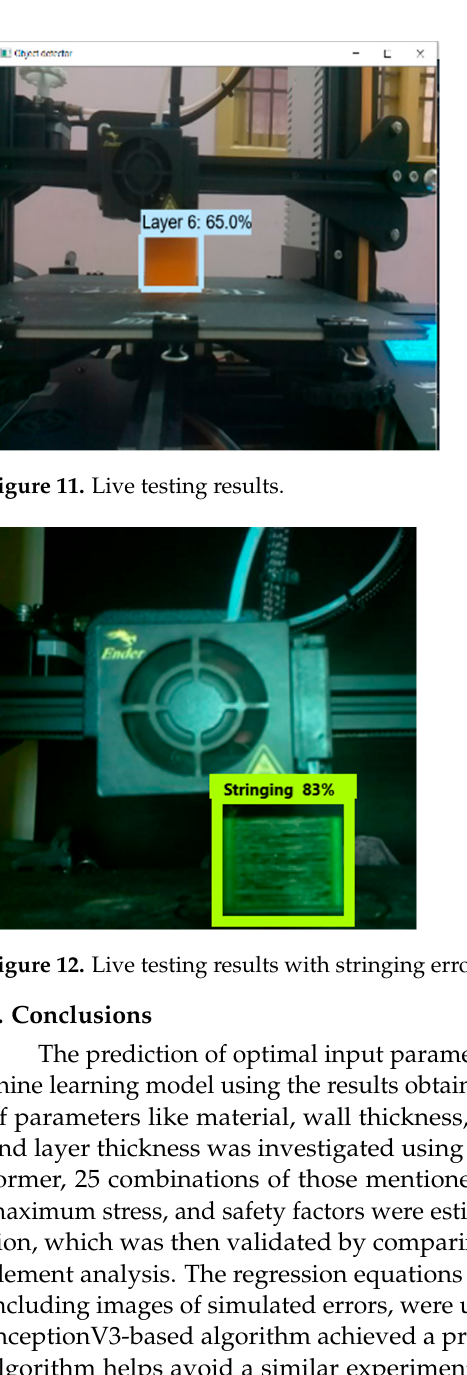
Figure 10. Questionnaire .